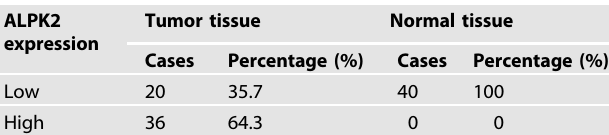
Table 1. Expression patterns of ALPK2 in bladder cancer tissues and normal tissues revealed in immunohistochemistry analysis.